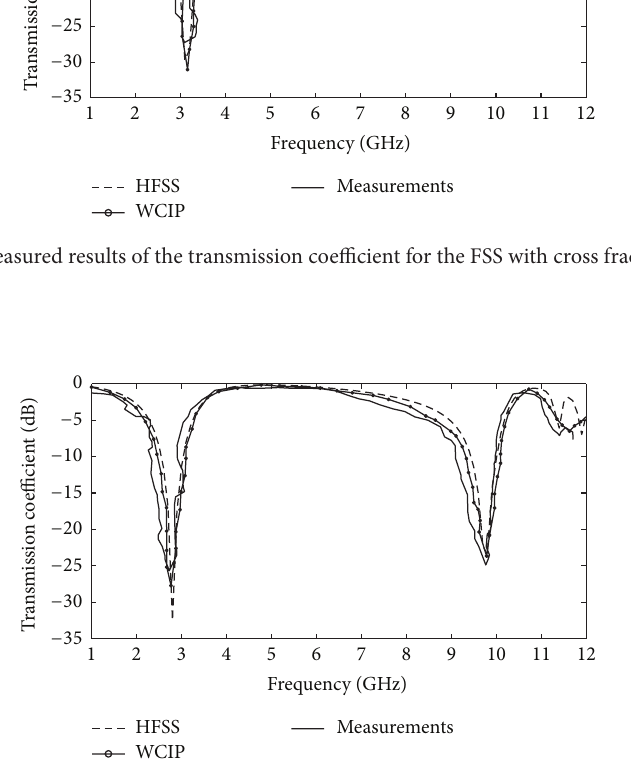
Figure 7: Simulated and measured results of the transmission coefficient for the FSS with cross fractal patch elements (FSS 2 ).